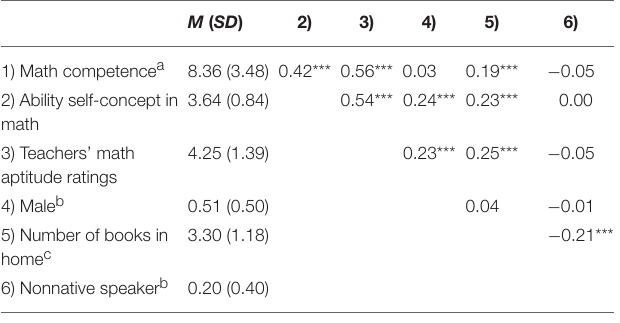
TABLE 1 | Means, standard deviations, and bivariate correlations. TABLE 2 | Regression of students’ ability self-concept in math on students’ gender and teachers’ math brilliance beliefs.